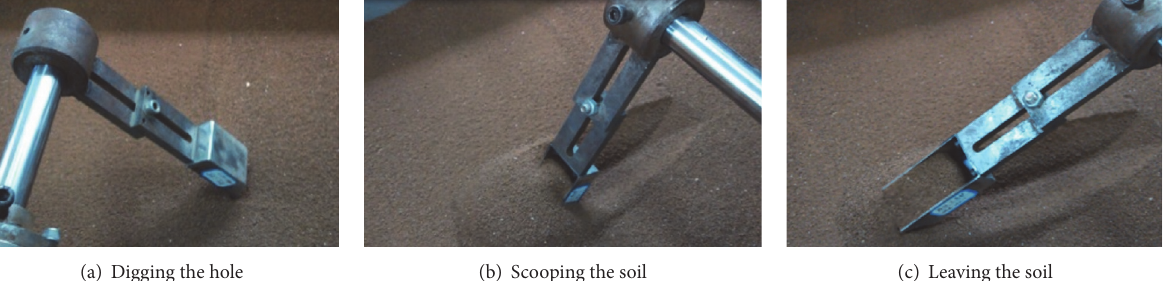
Figure 13: The process of digging and sampling.